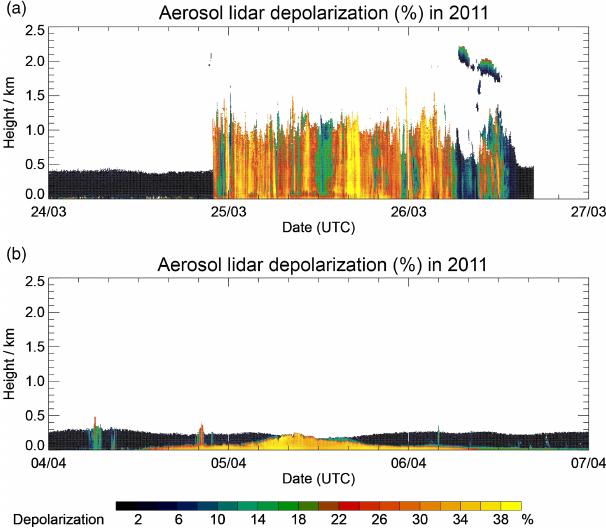
Figure 1. (a) Aerosol depolarization as measured by the lidar in- stalled at the Dome C station over the period 24–26 March 2011. (b) Aerosol depolarization as measured by the lidar installed at the Dome C station over the period 4–6 April